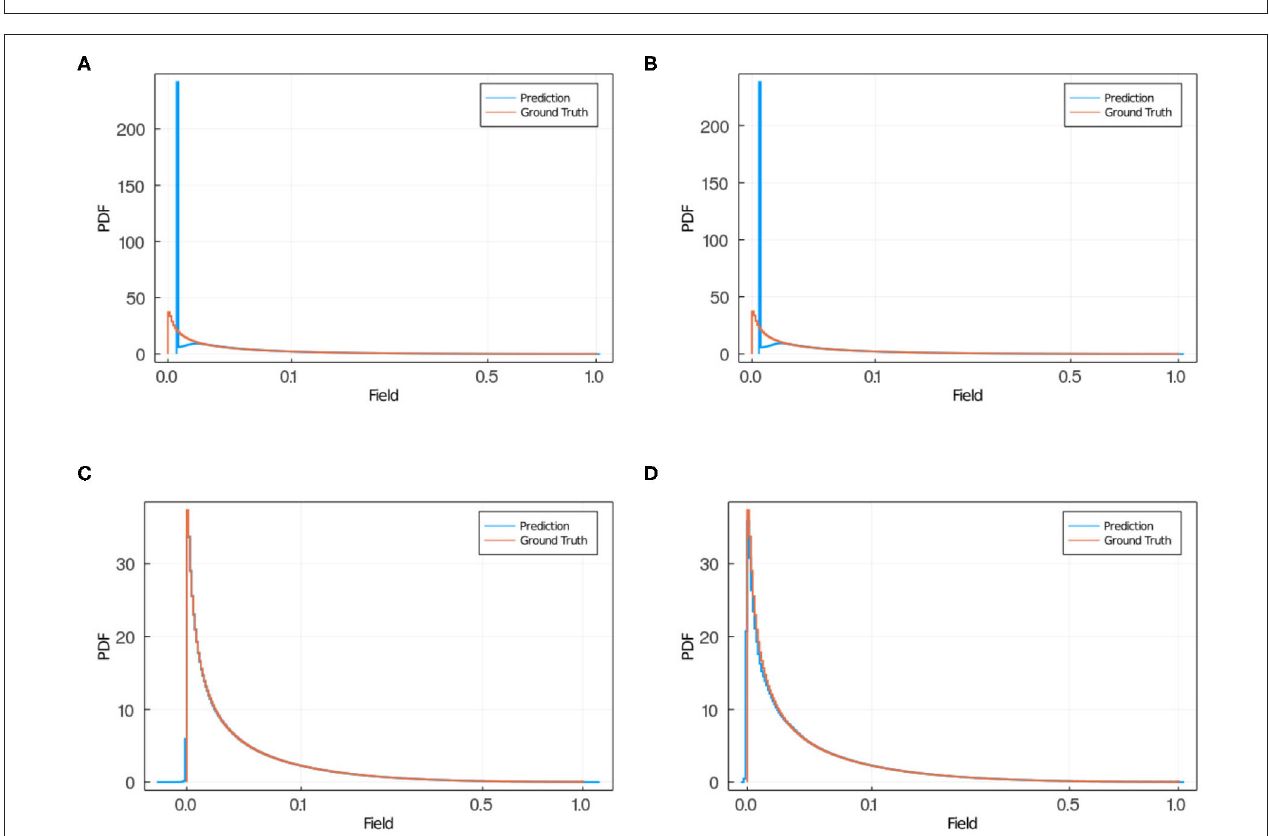
FIGURE 11 | PDF of field obtained via NN (blue) and ground truth (red) in the case of training using MSE, for (A) model 2 and (B) model 3 and for training using MAE, for (C) model 11 and (D) model 12. When using MSE (A,B) the NN predicts zero field values instead of low non-zero field values as the predicted PDF has a larger peak in zero than the ground truth PDF, and a smaller PDF for small non-zero field values compared with the ground truth PDF. When training using MAE (C,D) the prediction and ground truth PDFs overlap